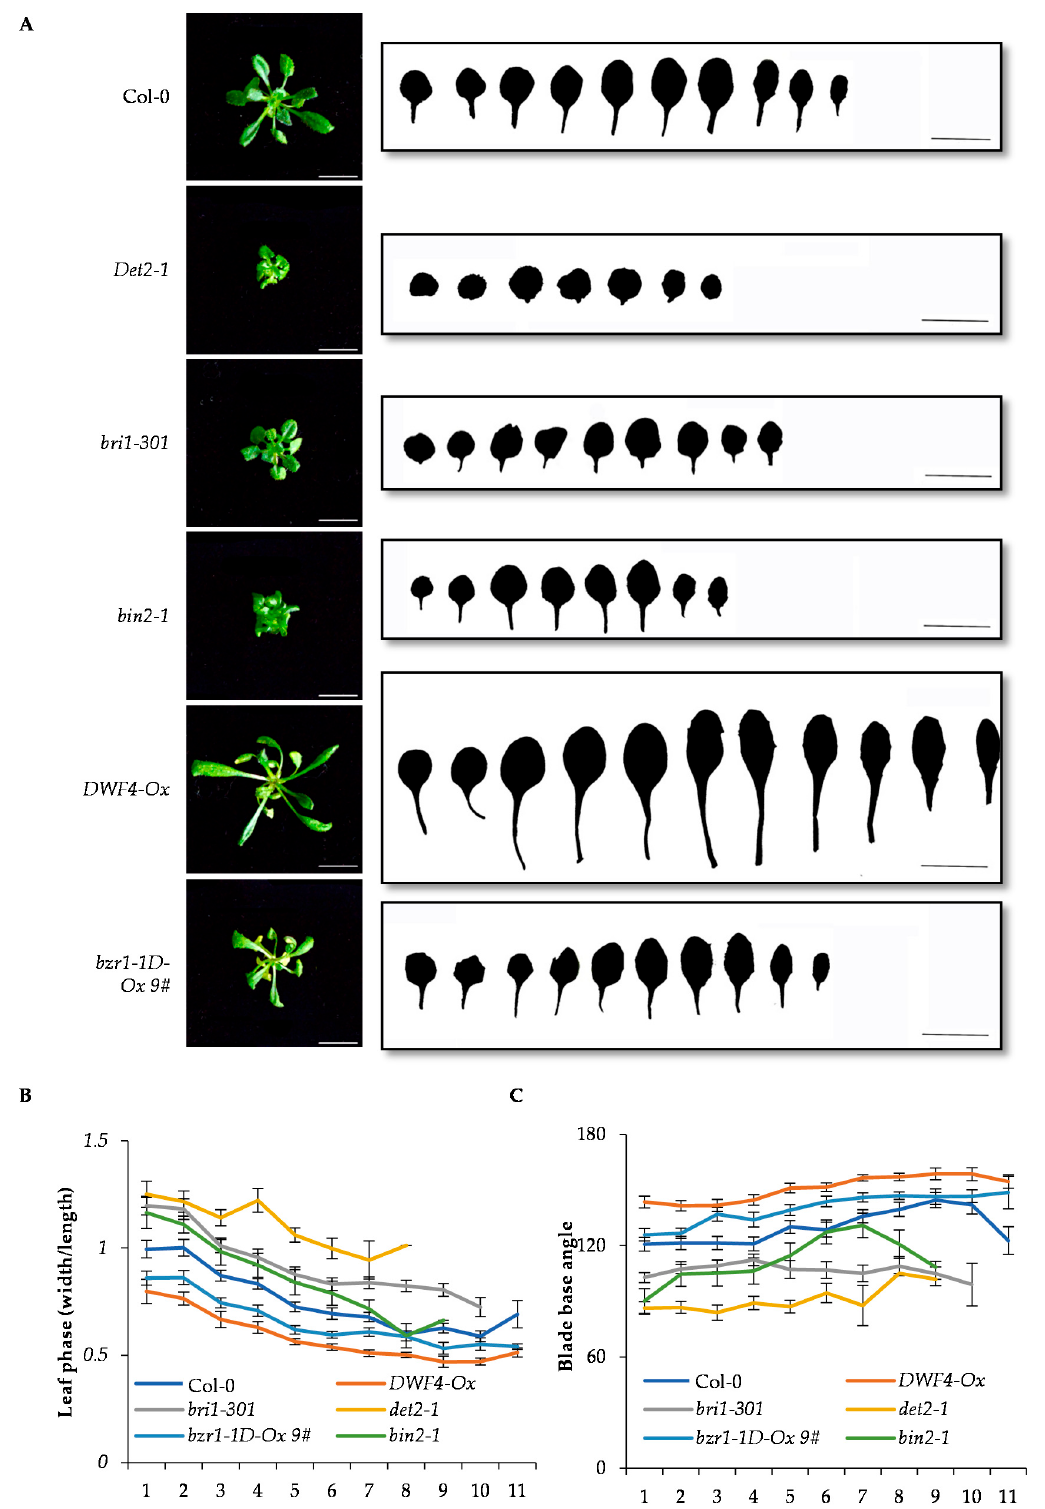
Figure 4. Brassinosteroid (BR) promotes vegetative phase change of plants. ( A ) The shape phenotypes of full expanded rosette leaves of wild type and different BR-related mutants. ( B ) The ratio of leaf width to leaf length of full expanded rosette leaves of wild type and different BR-related mutants. The leaf width and leaf length were measure from at least 30 plants. Error bars represent standard deviation. The x axis indicates the number of leaves. ( C ) The base angle of full expanded rosette leaves of wild type and different BR-related mutants. The leaf base angle were measure from at least 30 plants. Error bars represent standard deviation. The x axis indicates the number of leaves.